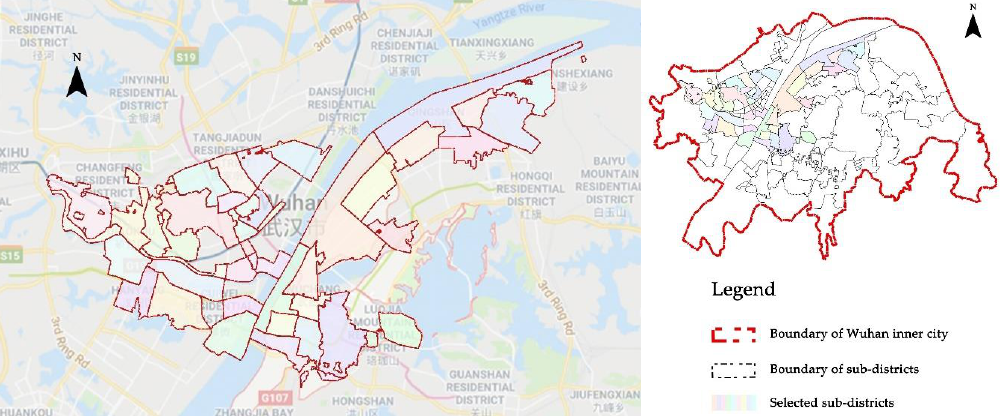
Figure 2. The study area and the 42 sub-districts in Wuhan.